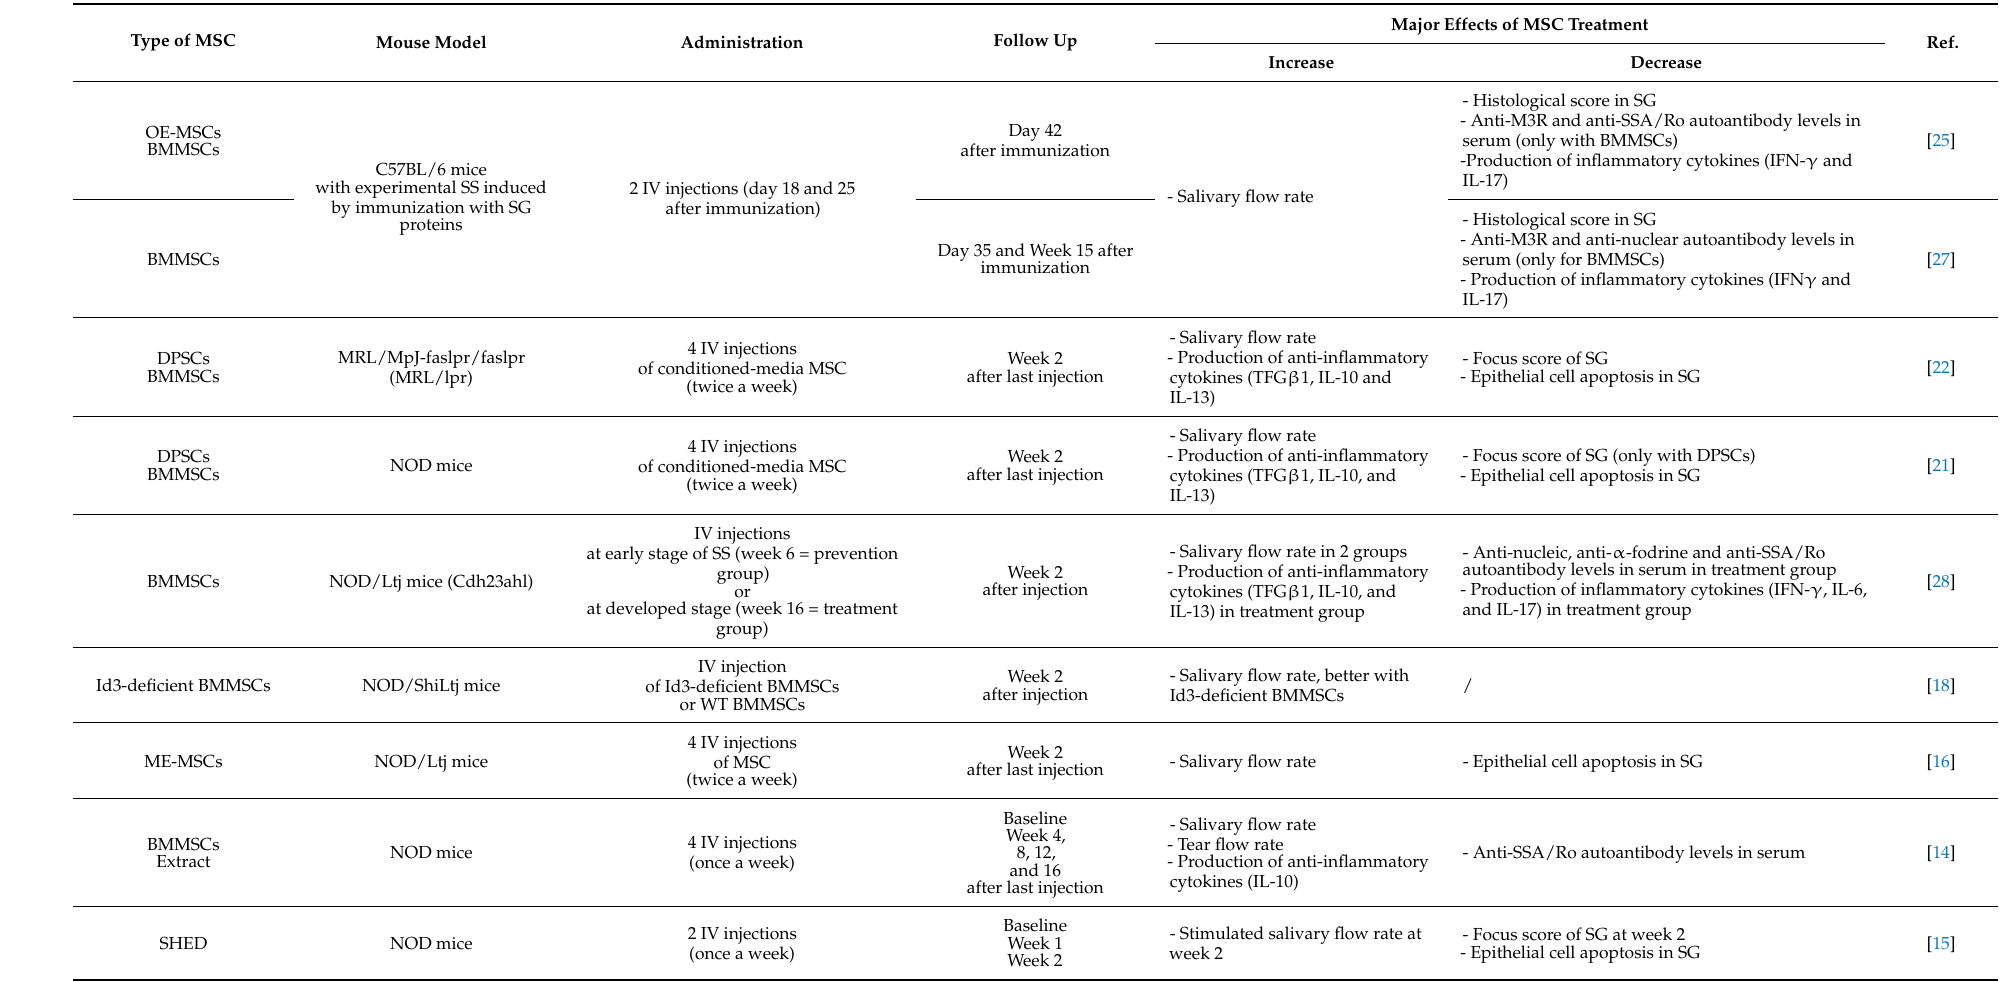
Table 1. Effects of MSC treatment in in vivo mouse models of Sjögren’s syndrome-like